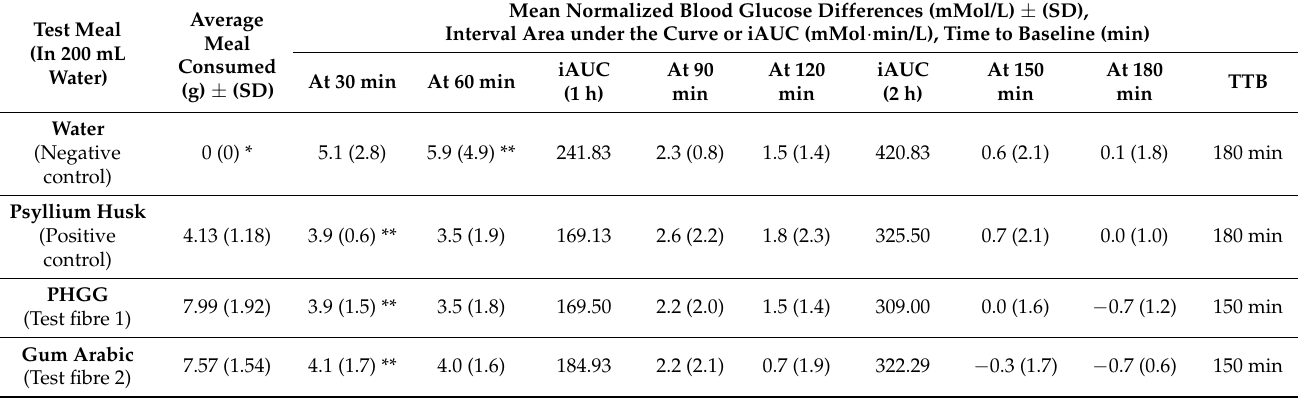
Table 2. Blood glucose parameters including mean normalized blood glucose values at 30 min intervals, interval area under the curve (iAUC), and time to baseline (TTB) shown for n = 10 participants in the study. Test Meal (In 200 mL